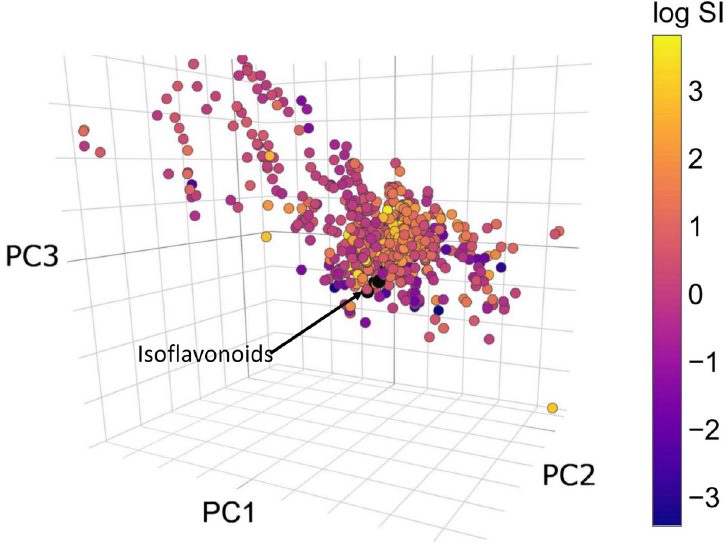
Fig 6. The location of MAO-A and MAO-B inhibitors beside Ononis isoflavonoids in chemical space color coded by their selectivity index (purple: Inhibiting selectively MAO-A, yellow: Inhibiting selectively MAO-B).